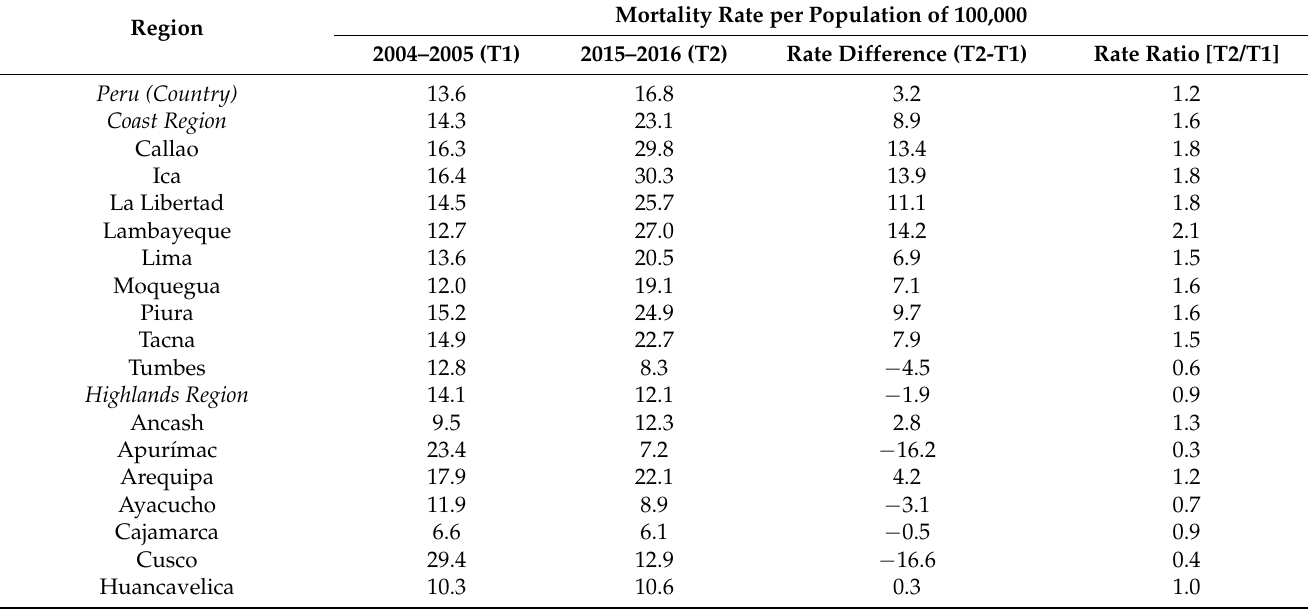
Table 4. Mortality and complications related to liver cirrhosis by region: Comparing periods of 2004–2005 and 2015–2016. Mortality Rate per Population of Region